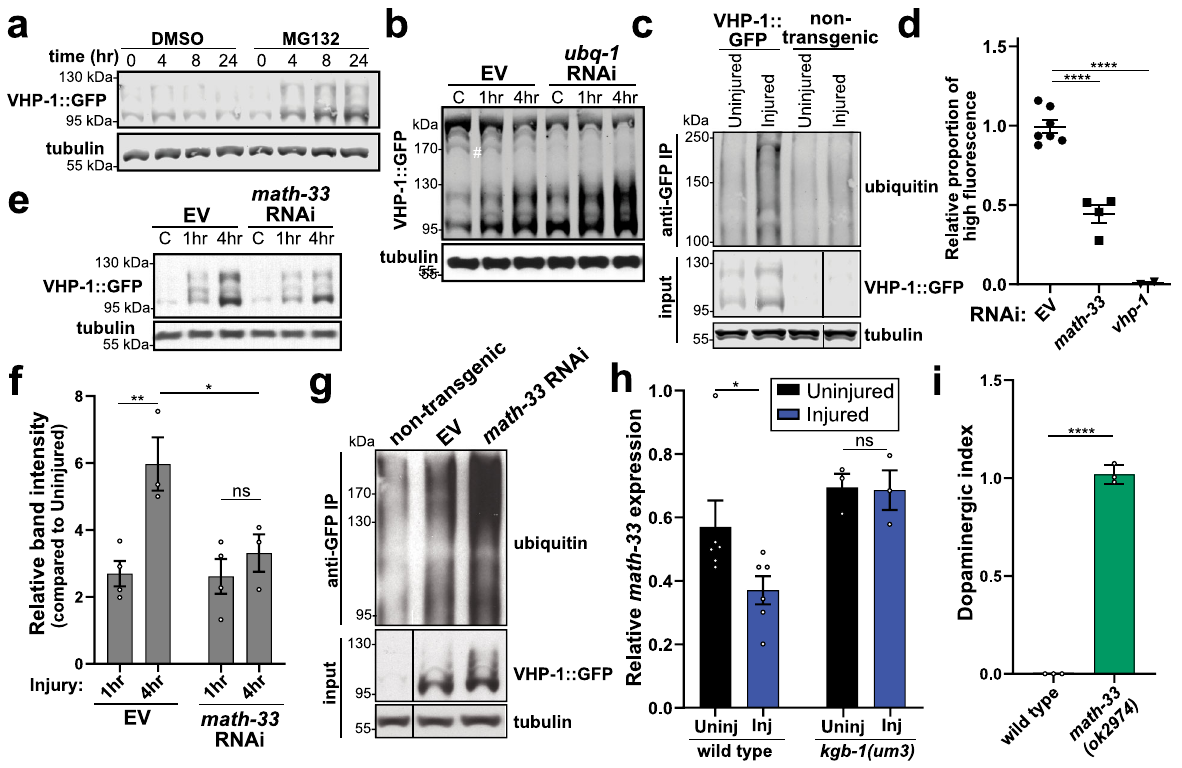
Fig. 7 Post-translational regulation of VHP-1 stability by components of the ubiquitin-proteasome system. a Western blot time-course of VHP-1::GFP following treatment with DMSO (vehicle) or 50 µ M MG132. Tubulin, load control. b Western blot of VHP-1::GFP without injury (control, C) or 1 and 4 hours (h) post injury. Worms treated with ubq-1 RNAi for 24 h. # ubq-1 RNAi sensitive high-MW bands. c Co-immunoprecipitation of VHP-1::GFP immunoblotted with anti-ubiquitin. Uninjured and injured non-transgenic worms (N2) as control. Input, VHP-1::GFP and tubulin from total worm extracts. d Effects of math- 33 (deubiquitinase, squares) or vhp-1 (triangles) RNAi on transgenic worms expressing VHP-1::mCherry in all tissues (PMD117). Flow cytometry data depicts the proportion of worms falling into a high- fl uorescence gate. Data are proportional to EV control from each independent experiment. Mean ± SEM, **** p < 0.0001 by one-way ANOVA with Sidak test. e Western blot of VHP-1::GFP from worms before (C, control) or 1 and 4 hours (h) after injury treated with math-33 RNAi. Tubulin, loading control. n = 4, uninjured and 1 h post injury, n = 3, 4 h post injury. f Quanti fi cation of western blots from Fig. 7e. Mean ± SEM. ** p = 0.0088, * p = 0.0427, not signi fi cant (ns) p = 0.8134 by two-way ANOVA with Tukey test. g Co-immunoprecipitation of VHP-1::GFP (anti- GFP IP) from injured worms on empty vector (EV) or math-33 RNAi immunoblotted with anti-ubiquitin. Injured, non-transgenic N2 worms as control. Input, VHP-1::GFP, and tubulin from total worm extracts. n = 4 biological replicates. h qPCR showing relative math-33 transcript abundance in wild type and kgb-1 (um3) mutant worms with (Inj) and without (Uninj) injury. Mean± SEM, * p = 0.0135 by two-way ANOVA with Sidak test, WT n = 6, kgb-1(um3) n = 3. i Large-particle fl ow cytometry of wild type, PMD13, and math-33(ok2974) mutants, PMD173, two days post trauma. Dopaminergic GFP index indicates relative loss of dat-1p::GFP signal of injured math-33(ok2974) mutants compared to injured wild type worms. Mean ± 95% CI. **** p < 0.0001 by two-sided paired t -test. n = 4149, wild type, and n = 2601, math-33(ok2974) , over three independent trials. Positive values indicate reduced loss of fl uorescence when compared to age-matched uninjured controls. A value of one indicates no change of fl uorescence compared to uninjured